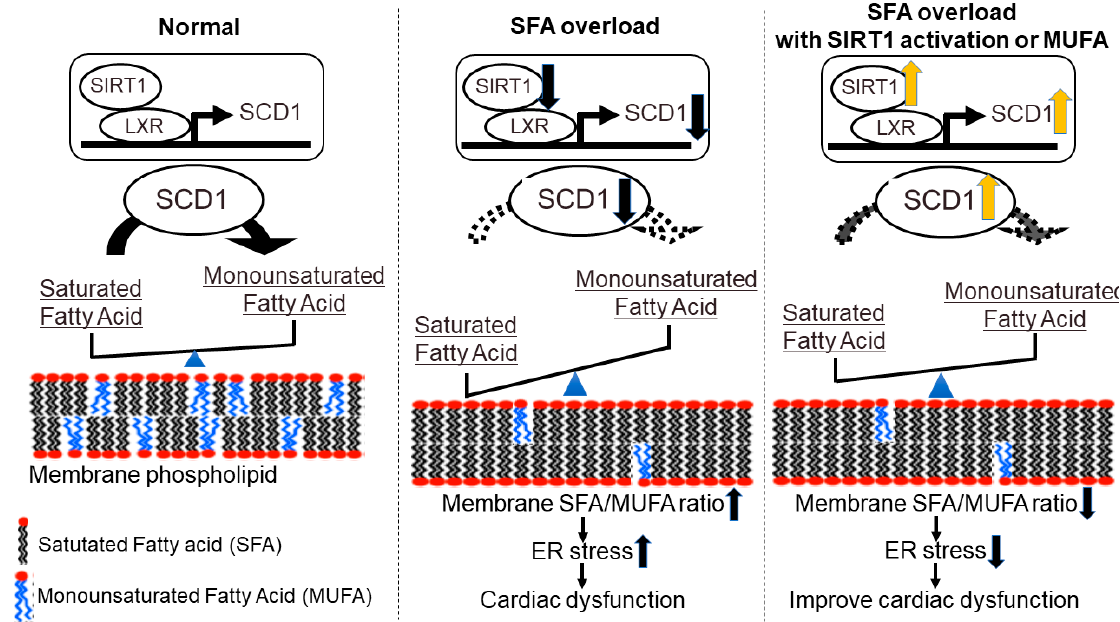
Figure 2. The relationship between cardiomyocyte membrane fatty acid composition and contractile dysfunction. Cardiomyocyte membrane fatty acid composition, the balance of SFA and MUFA, are well maintained by the SIRT1-LXR-SCD1 axis. SFA overload decreases the activity of the SIRT1- LXR-SCD1 axis, which leads to a high ratio of membrane SFA/MUFA. An increase in membrane SFA/MUFA ratio triggers ER stress and relates to cardiac contractile dysfunction, mainly diastolic dysfunction. Intervention with either SIRT1 activation or MUFA supplementation during SFA over- load improves membrane SFA/MUFA ratio, ER stress, and contractile dysfunction. A black arrow facing upwards indicates an increase and downwards indicates a decrease. ER, endoplasmic retic- ulum; LXR, liver X receptor; MUFA, monounsaturated fatty acid; SCD1, stearoyl-CoA desaturase I; SFA, saturated fatty acid; and SIRT1, sirtuin1. 5. Developing Heart Failure Therapy by Nutritional and Pharmacological Interven- tion 5.1. Statin and Fibrate Therapy Currently, there are only a few ways to intervene in myocardial FA metabolism. In the late 1990s, the structure and function of PPAR α were elucidated, and it became clear that one of the targets of action of statins and fibrates was activation of PPAR α [103,104]. Statin, as an HMG-CoA reductase inhibitor, is known to lower cholesterol and inhibit car- diovascular events, and PPAR γ activation in macrophages has also been reported to be involved in the anti-atherosclerotic effect of statin [105]. Statins have the potential to pre- vent cardiac hypertrophy through multifaceted activation of PPAR α and PPAR γ and by inhibiting inflammation and fibrosis [106,107]. Fibrate has been reported to inhibit cardiac hypertrophy and heart failure through suppression of PI3K/Akt/mTOR signaling and reg- ulation of HMGB1 expression, in addition to activation of PPAR α [104]. Kawamoto et al. revealed that activation of PPAR α after pressure-overload surgery increased PPAR α -tar- get genes related to FA metabolism and preserved cardiac contractile function. This sug- gests that in the early stages of heart failure, the role of PPAR α activation may be to restore FA oxidation, thereby, restoring energy production and cardiac function [108]. Pemafi- brate was developed based on the concept of increasing the selectivity of fibrates for PPAR α and reducing the burden on the liver and kidneys. The PROMINENT trial, a large- scale clinical trial of pemafibrate, is currently underway worldwide [109], and we look forward to the results to know if it has a preventive effect on heart failure.